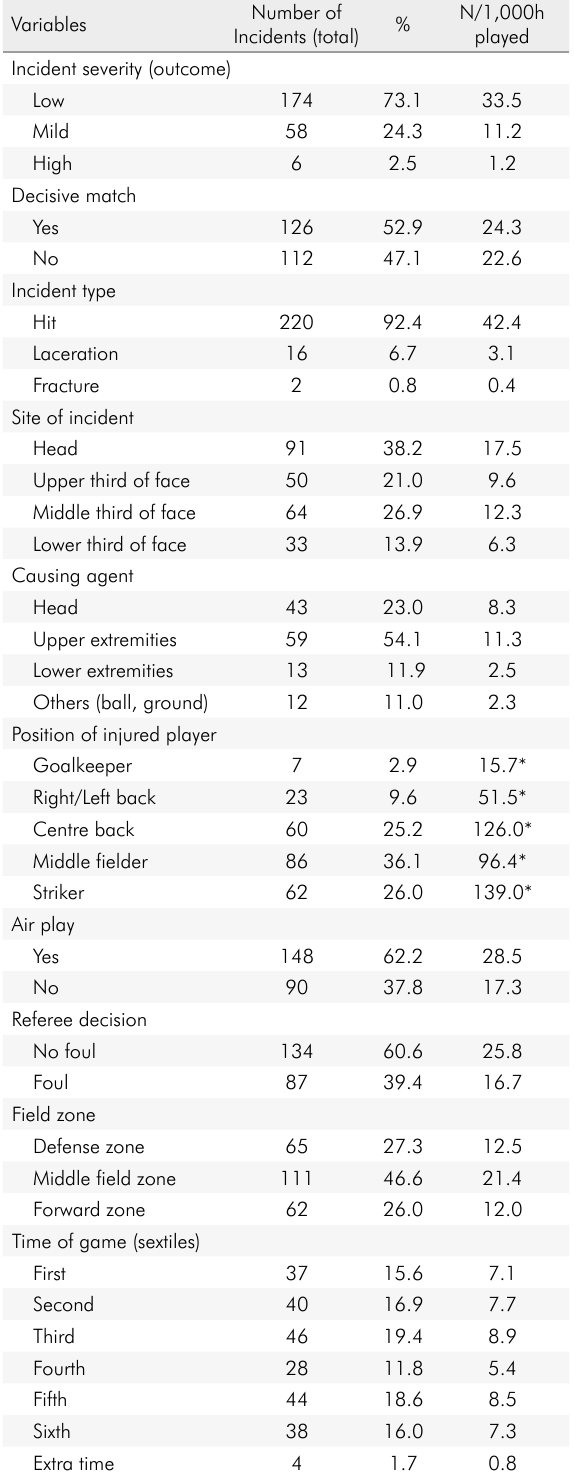
Table 1. Distribution of incidents by variables of interest during FIFA World Cups of 2014/2018 and FIFA Confederation Cup of 2017 (n =